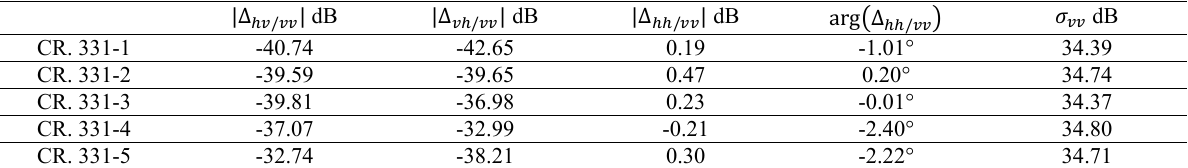
Table 1. The integral estimation derived crosstalk, channel imbalance and RCS of VV polarization.